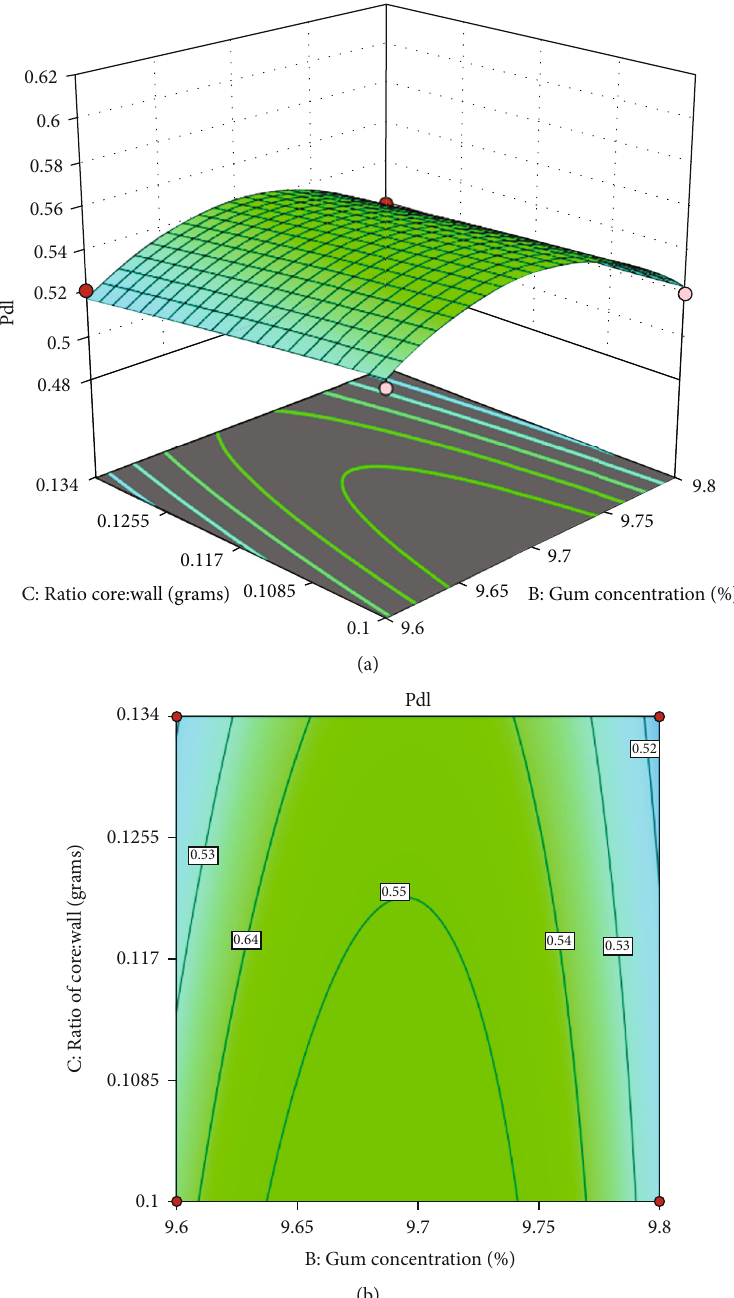
Figure 2: Surface plot (a) and contour plot (b) for PDI